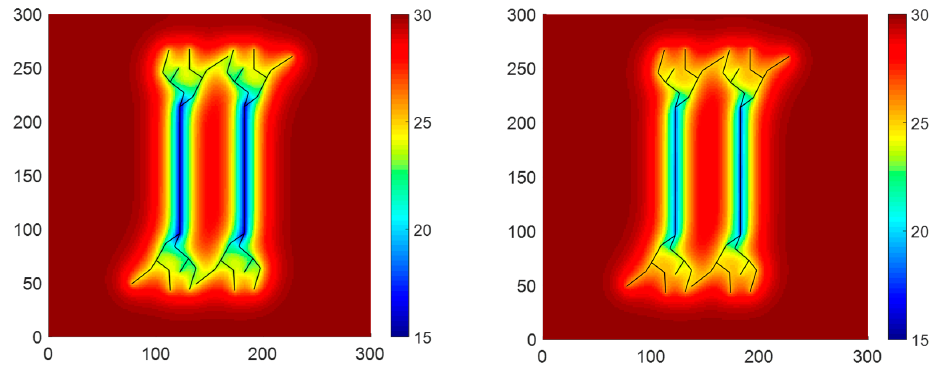
Figure 9. Formation pressure (constant conductivity vs. variable conductivity).